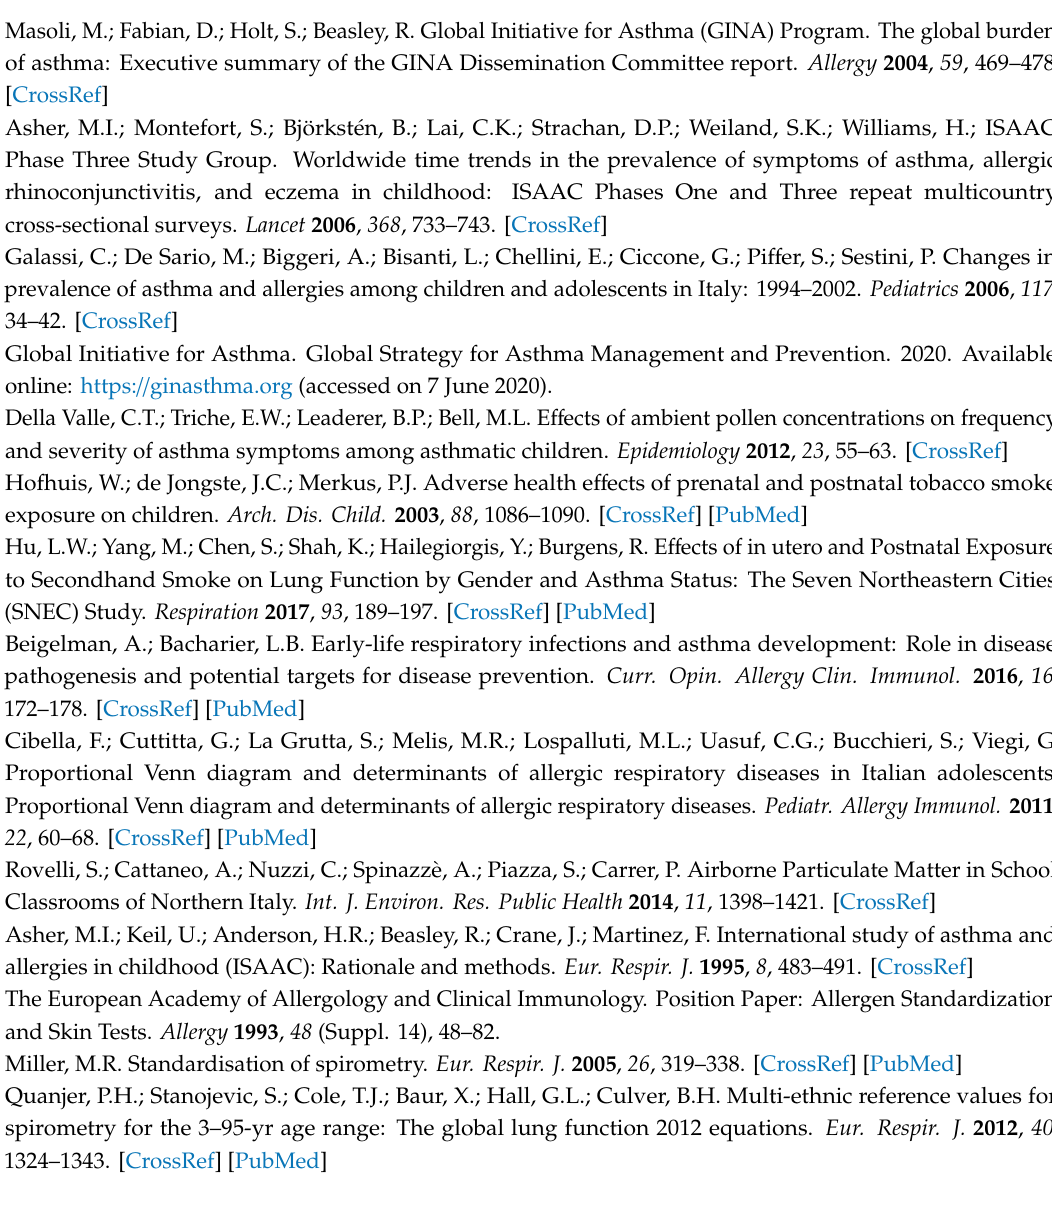
Table S1: Multiple linear regression model for FEF 25–75% (z-score), separately for female and male children, Table S2: Multiple linear regression model for FEF 25–75% (z-score) among 1102 “healthy” subjects only, Table S3: Multiple linear regression model for FEF 25–75% / FVC